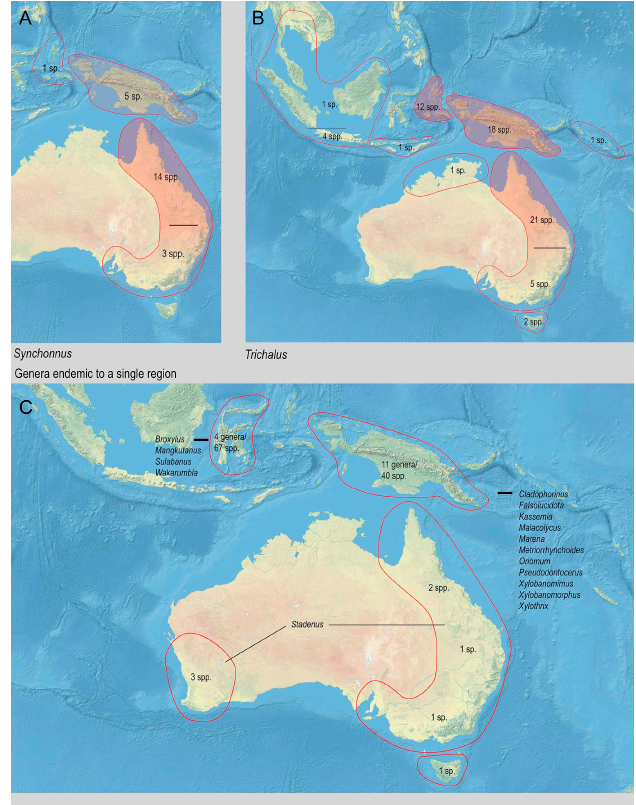
Figure 7. Distribution and diversity of Metriorrhynchina genera. ( A ) Synchonnus Waterhouse, 1879; ( B ) Trichalus Waterhouse, 1877; ( C ) The genera endemic to a single region.